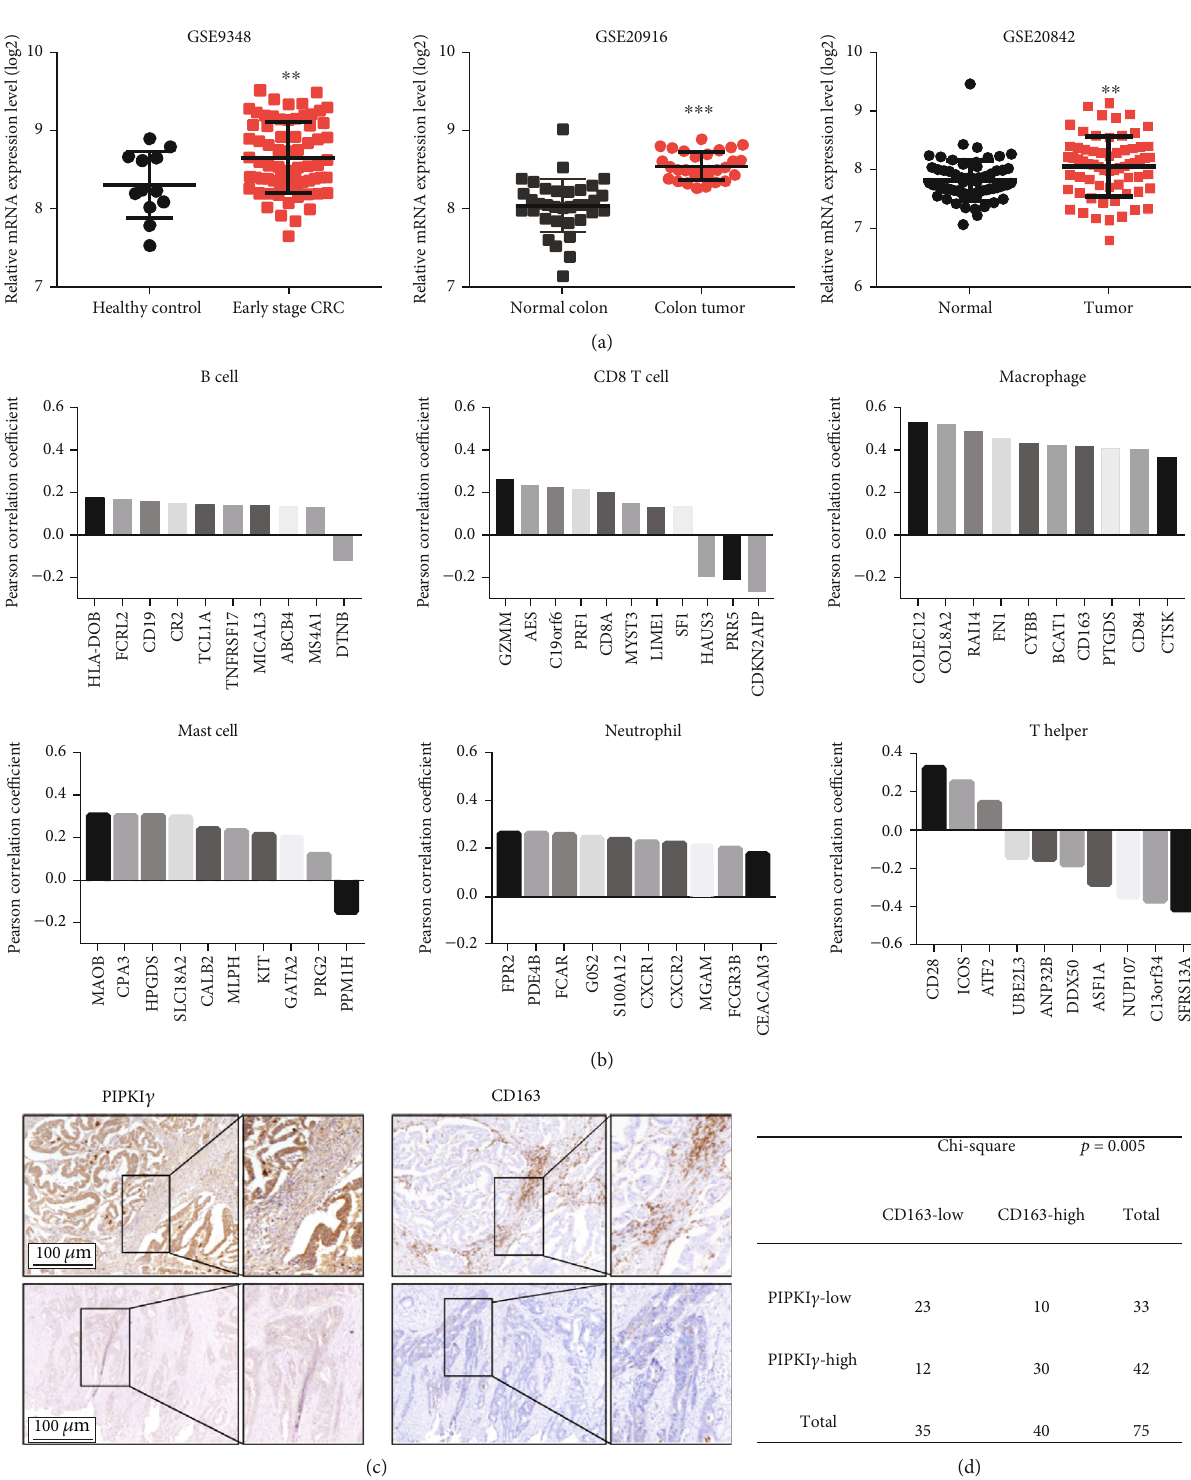
Figure 1: Increased PIPKI γ expression positively correlated with TAM in fi ltration in CRC. (a) mRNA expression levels of PIP5K1C in CRC tumor tissue and corresponding nontumor tissue. (b) Correlation between PIP5K1C and speci fi c gene signatures of B cells, CD8 + T cells, macrophages, mast cells, neutrophils, and T helper cells. (c) Immunohistochemical analysis of PIPKI γ expression and CD163 in a human CRC tissue microarray. Representative high and low PIPKI γ expression images are shown in the left panel, and the corresponding CD163 staining results are shown in the right panel. (d) The statistical results for PIPKI γ and CD163 tissue scores for low and high staining determined in the CRC cohort. Scale bar: 100 μ m. ∗ p < 0 : 05 , ∗∗ p < 0 : 01 , ∗∗∗ p < 0 : 001